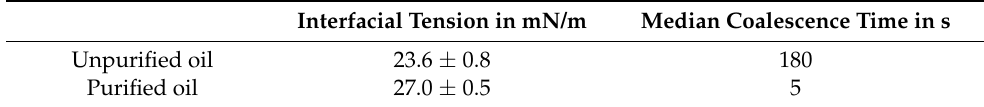
Table 2. Differences in the measured values for unpurified and purified